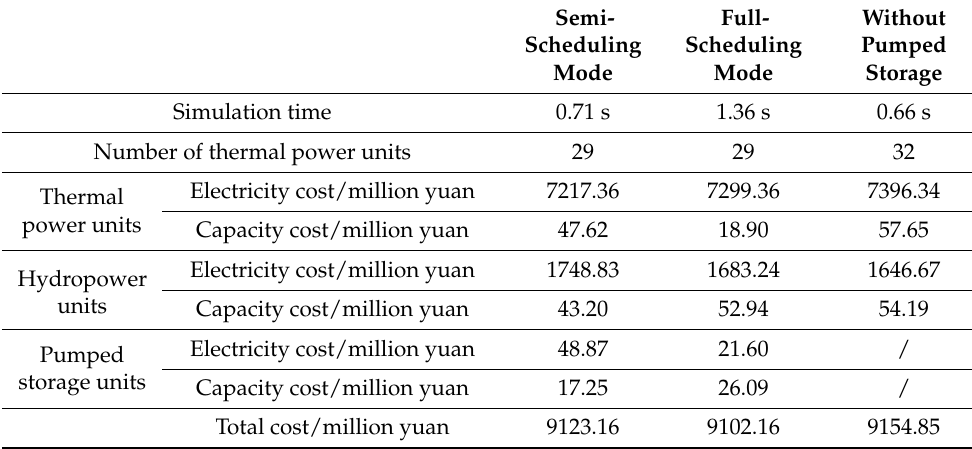
Table 3. Comparison of 0ptimization results under different scheduling